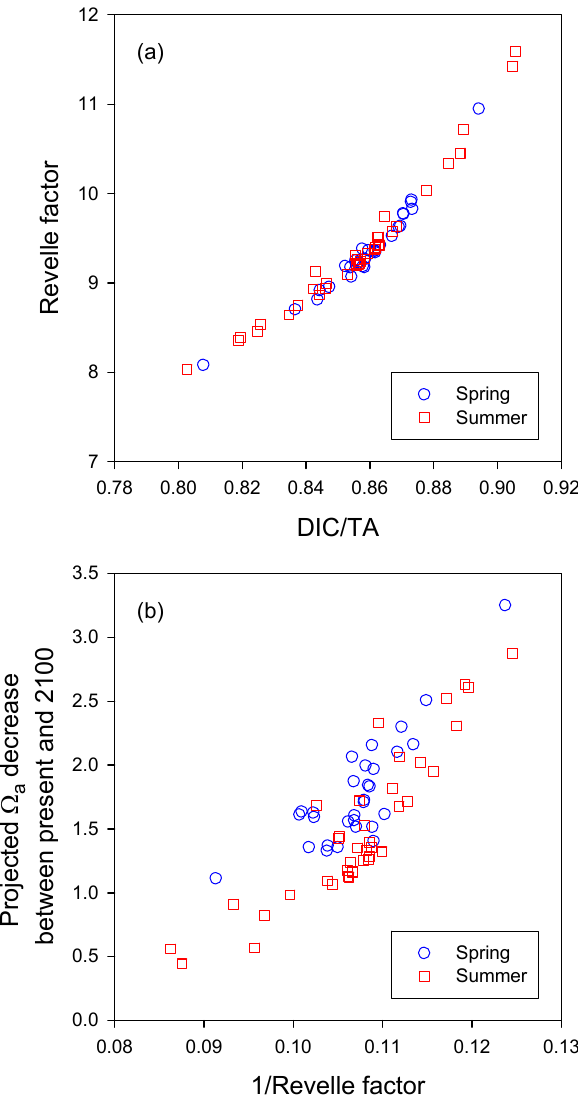
Fig. 9. Plots of (a) Revelle factor vs. DIC/TA ratio, and (b) differ- ence of (cid:127) a between the predicted (cid:127) a in 2100 and its present value ( 1(cid:127) a ) vs. the reciprocal of the Revelle factor (1/Revelle factor) for the surface waters in the East China Sea during spring and summer